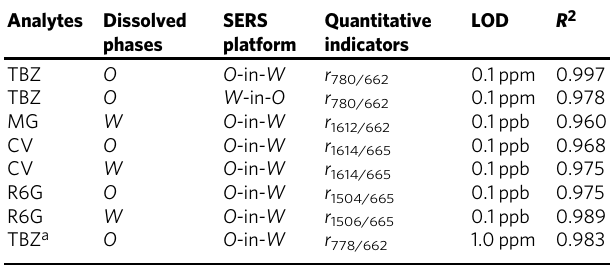
Table 1 Performance of the quantitative SERS analyzer Analytes Dissolved SERS phases